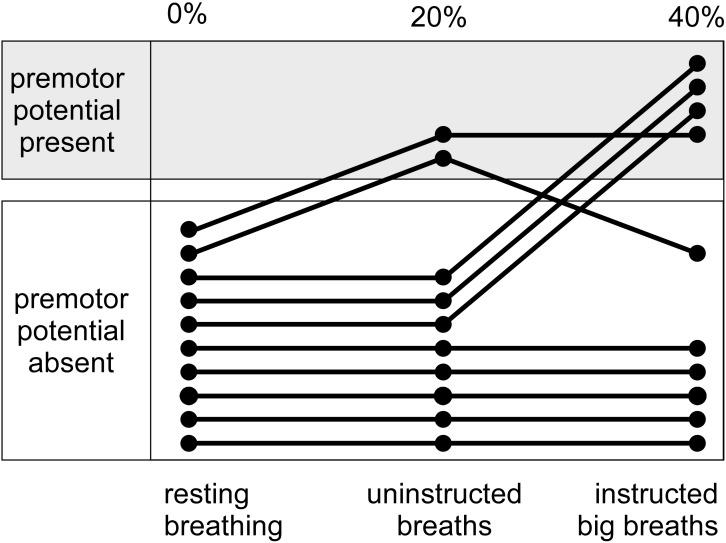
Incidence of premotor potentials for interspersed instructed big breaths and uninstructed standard breaths during a trial of unloaded breathing. Shows, for individual participants, the distribution of premotor potentials during instructed big breaths and uninstructed standard breaths, compared to a trial of resting breathing.